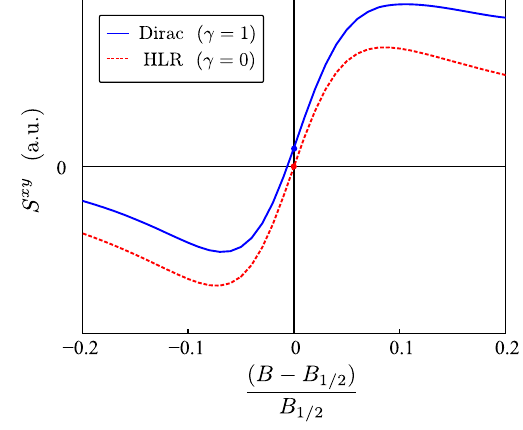
FIG. 2. Field dependence of S xy . In addition to having a zero or nonzero value at half-filling ( B ¼ B 1 ), the asymmetric field = 2 dependence of the transverse thermopower (Nernst) signal dis- tinguishes between the HLR state with zero Berry phase ( γ ¼ 0 ) and the particle-hole symmetric Dirac state with π Berry phase ( γ ¼ 1